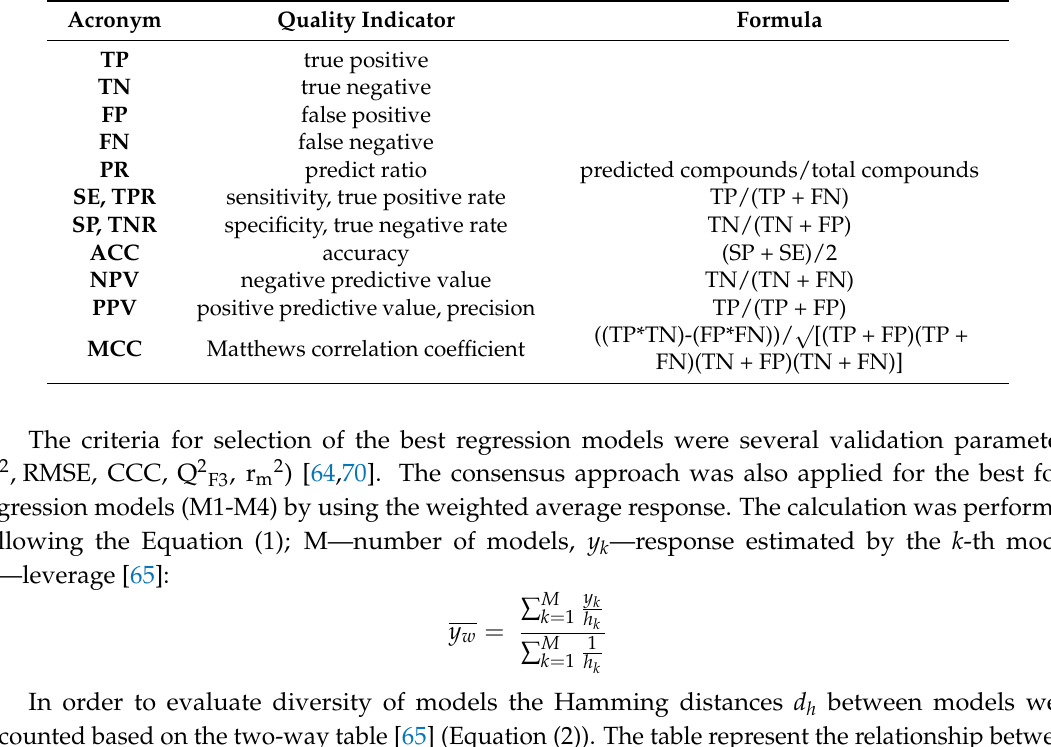
Table 5. Quality indicators for evaluation of different classification